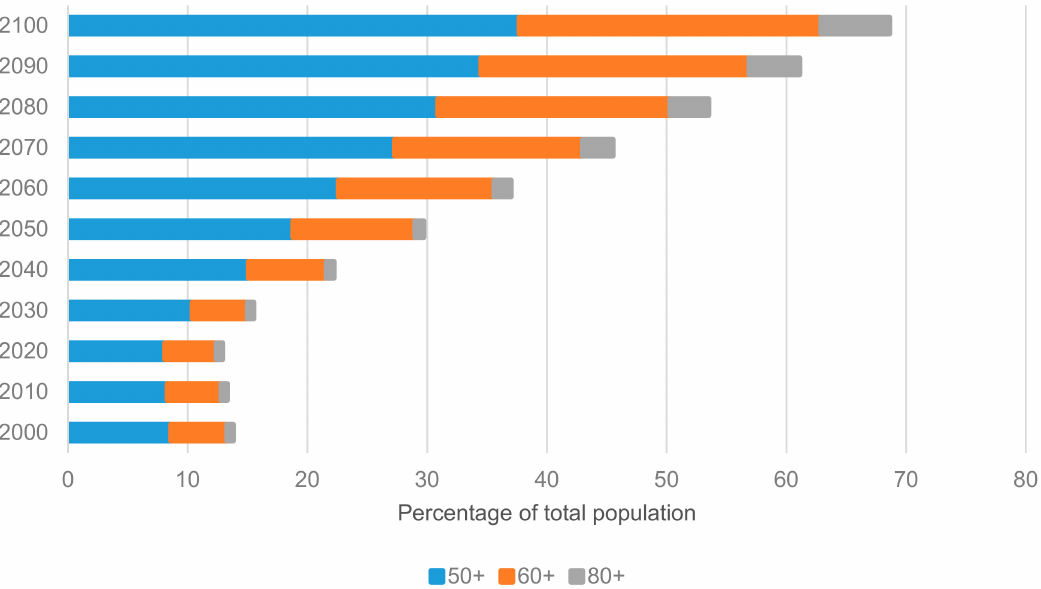
Figure 1. Predicted change in the proportion of the Zimbabwean population in older age groups (Authors adapted from United Nations, Department of Economic and Social Affairs, Population Division